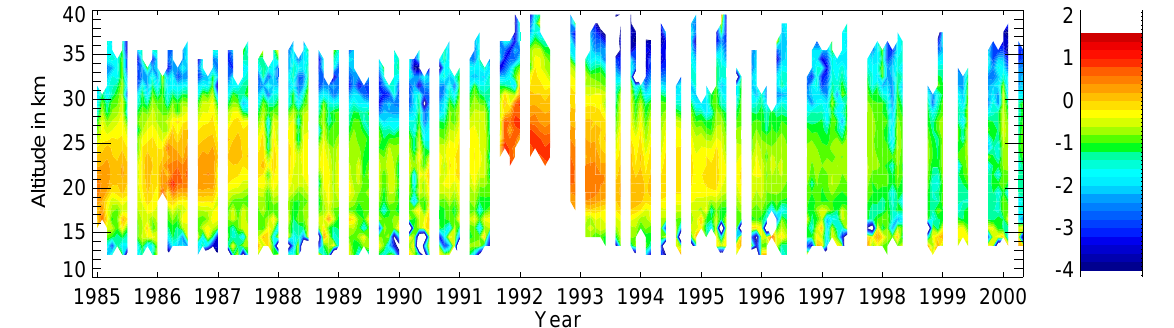
Fig. 1. Temporal and vertical evolution of log 10 (N [ cm − 3 ] ) at the equator, derived from SAGE II extinction profiles for the period October 1984 up to March